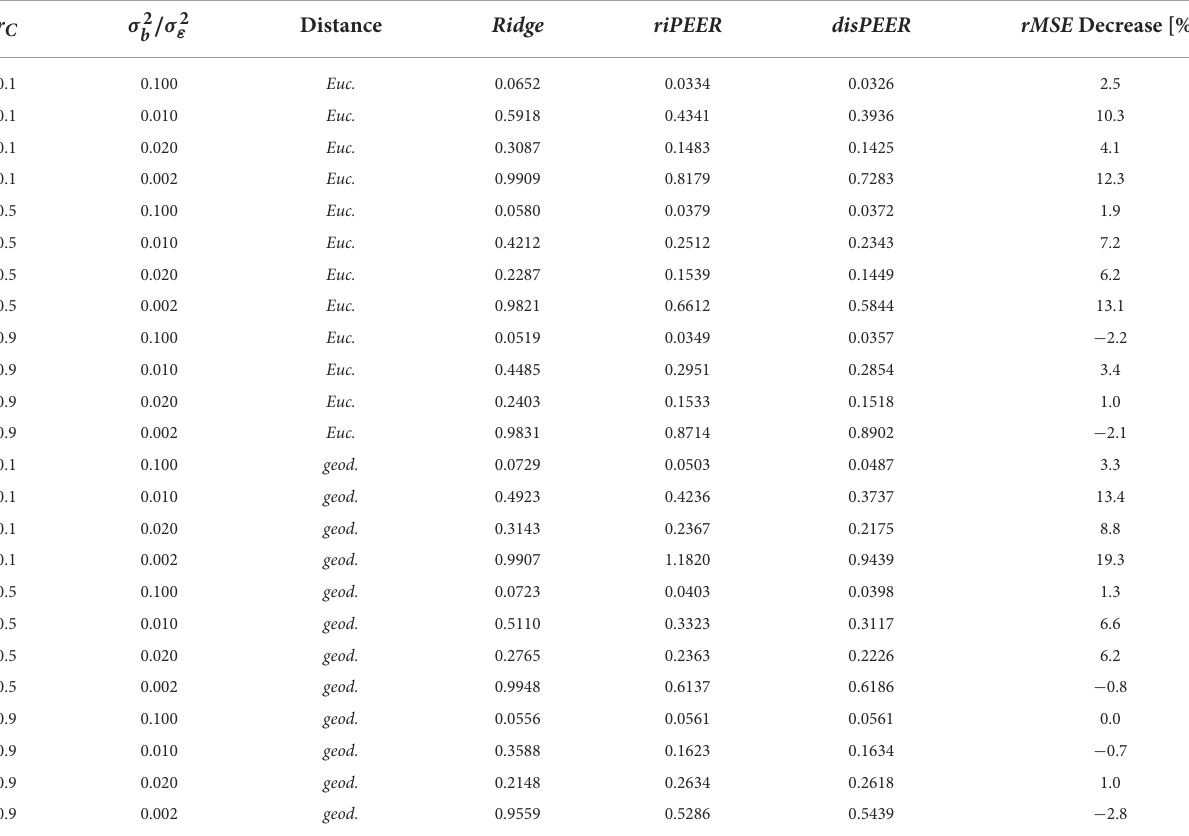
TABLE 2 rMSE (median) results for ridge , riPEER , and disPEER methods with h = 5 and h = 100 for Euclidean and geodesic distances, respectively, for σ 2 b ∈ { 0.1,0.01 } and σ 2 ε ∈ { 1,5 }